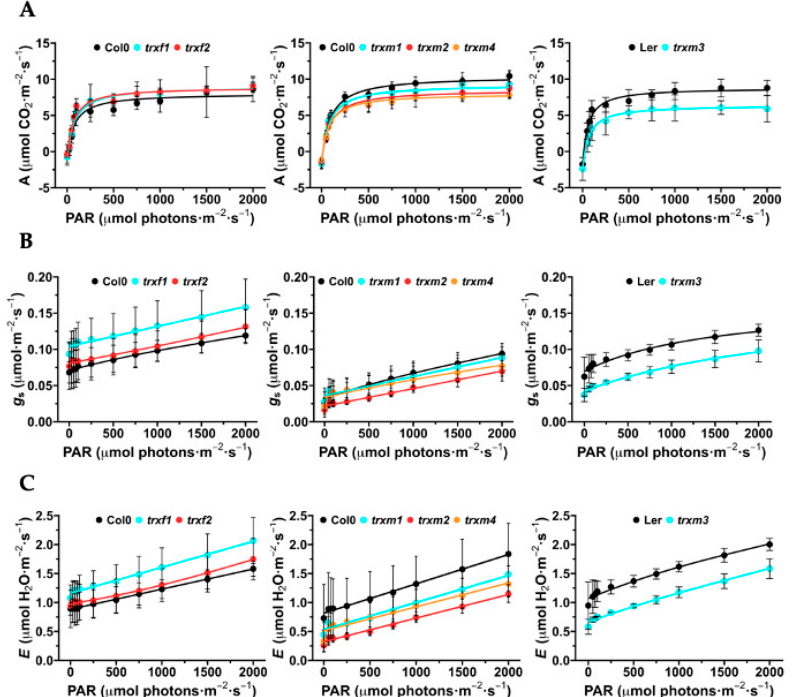
Figure 5. Infrared gas analyser measurements in WT (Col0 and Ler) and trxf and trxm mutant lines. ( A ) Light-response curves for the rate of photosynthetic CO 2 assimilation ( A ); ( B ) stomatal conductance ( g s ); ( C ) transpiration ( E ). Arabidopsis plants were grown for 4